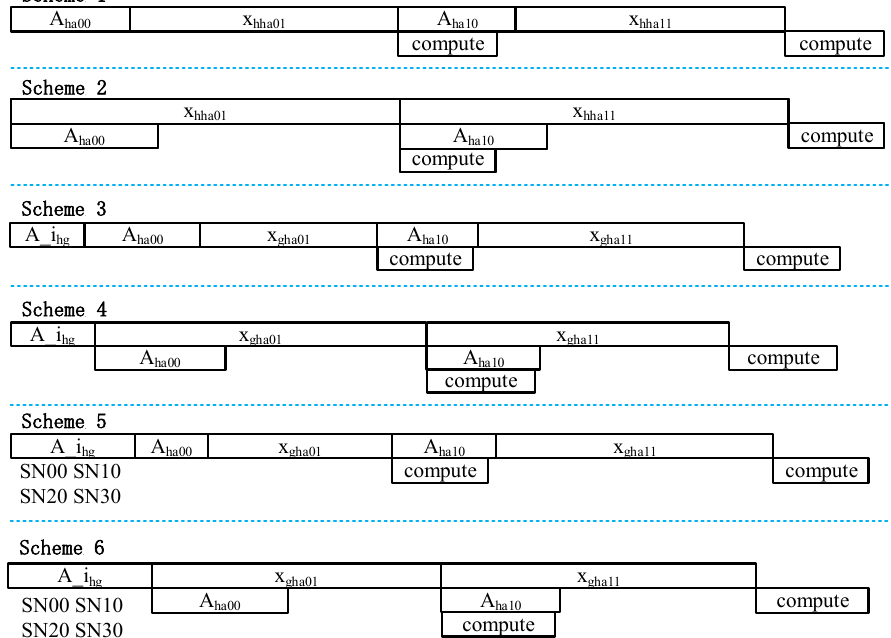
Figure 6. Six algorithm structures. We introduce the first two schemes (1 and 2) in Section 4.3 and